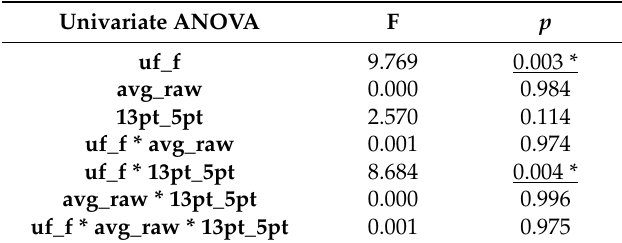
Table 4. Univariate ANOVA test on the recorded deviations.